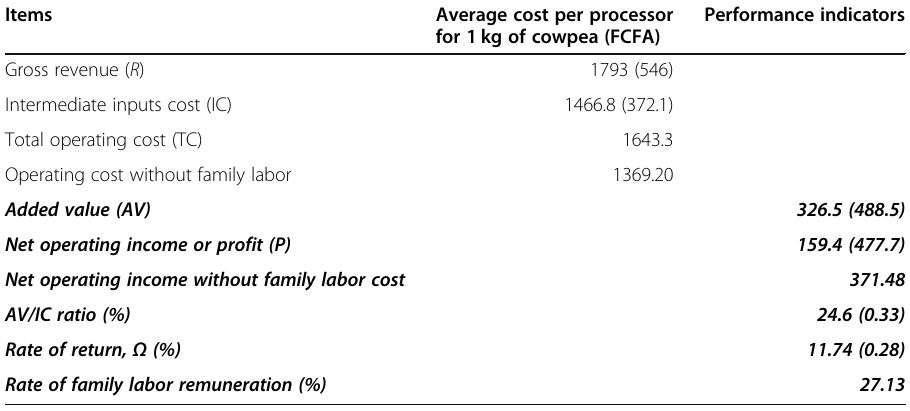
Table 5 Aggregate operating account of “ atta ” production from white cowpea Items Average cost per processor for 1 kg of cowpea